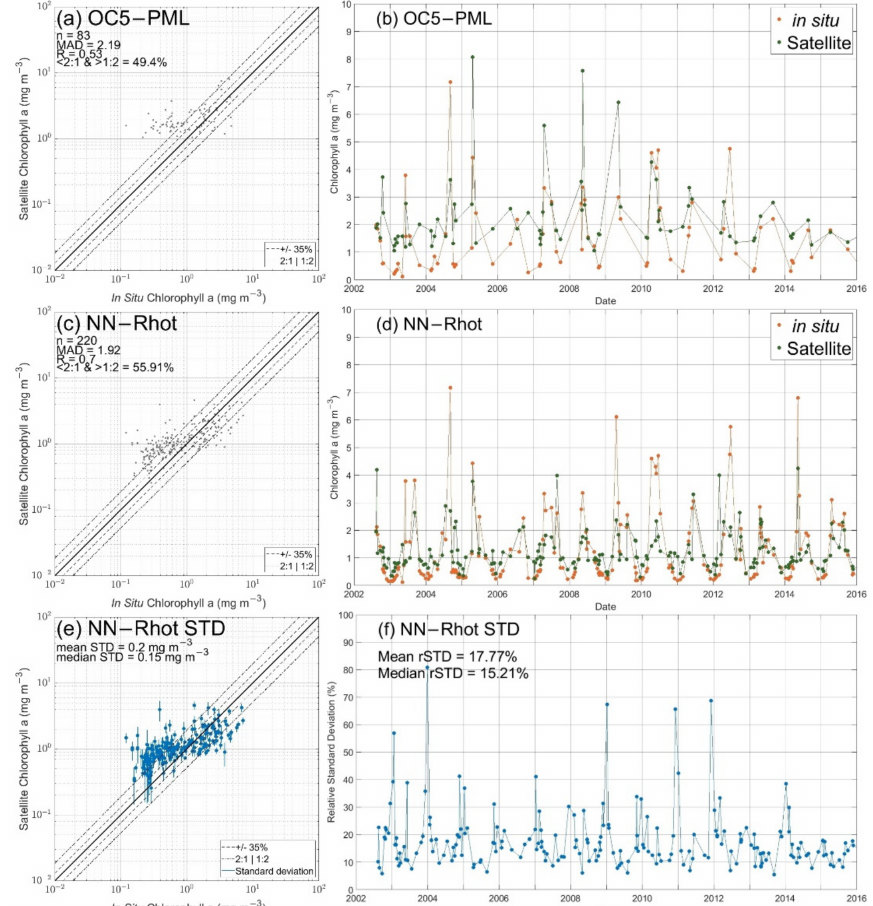
Figure 12. Chlorophyll estimates for the Stonehaven time series, for ( a , b ) OC5-PML algorithm and ( c , d ) NN-Rhot. Standard deviation and relative standard deviation from the ensemble NN-Rhot approach ( e , f